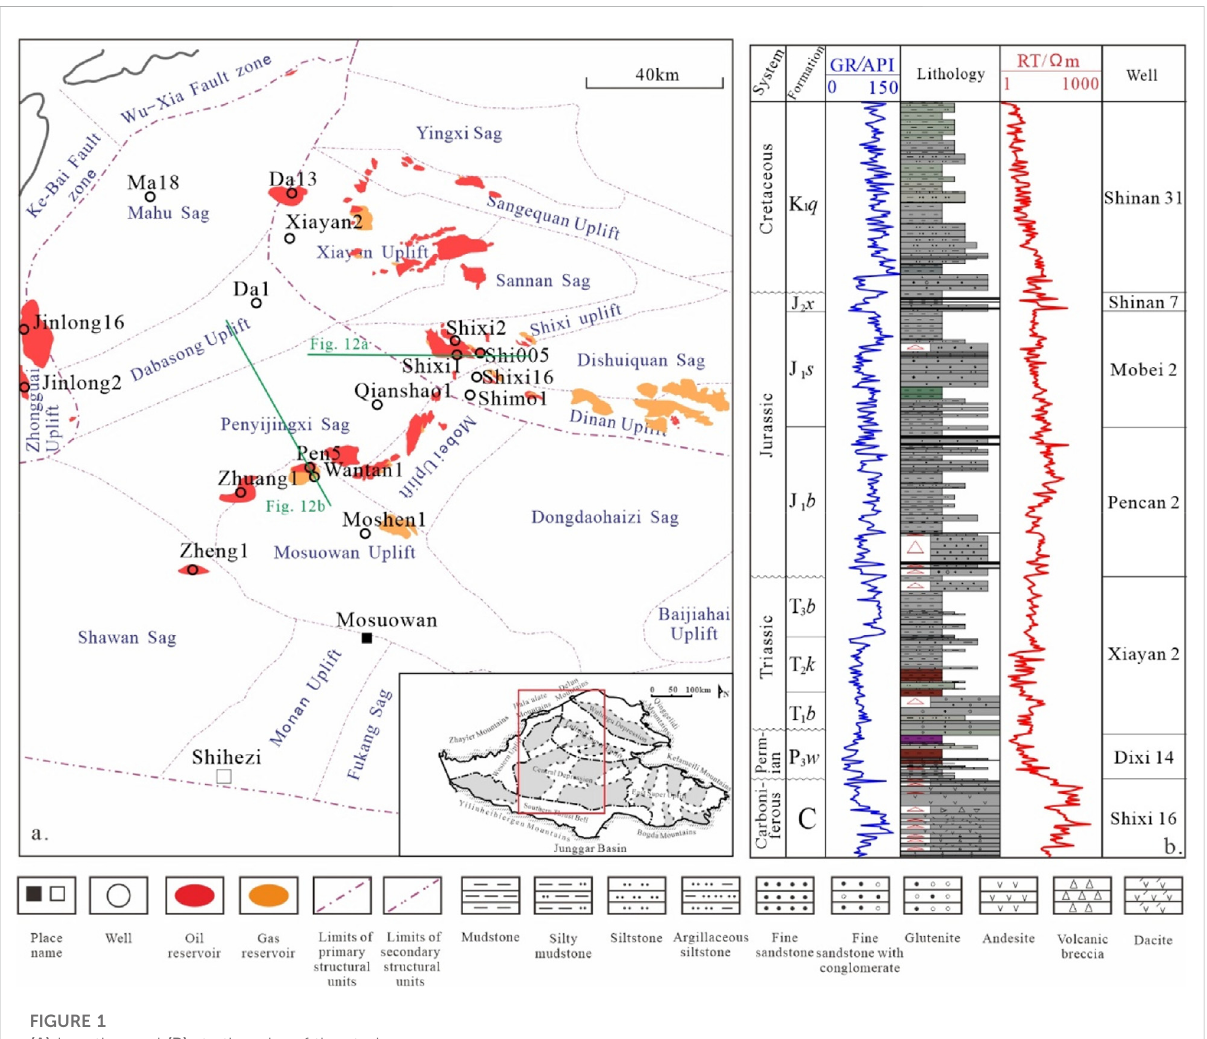
FIGURE 1 (A) Location and (B) stratigraphy of the study